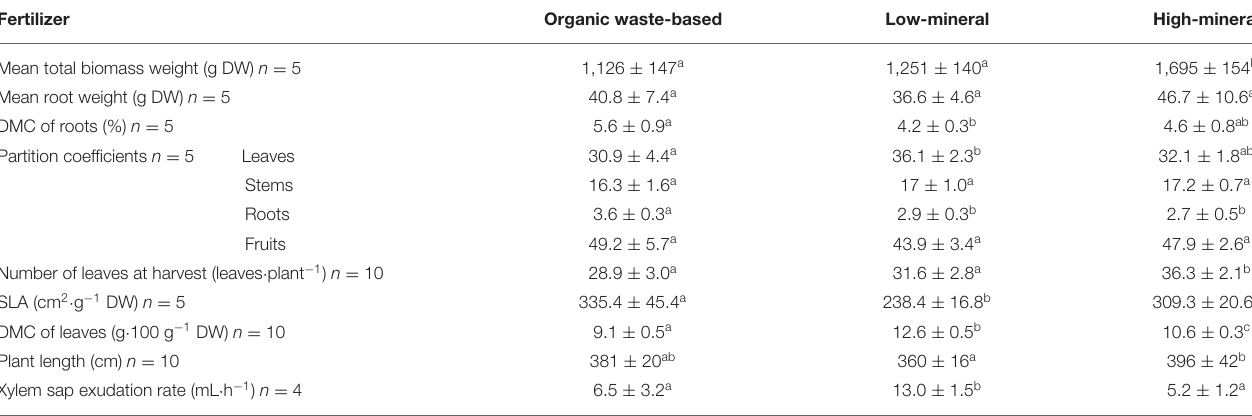
TABLE 3 | Biomass parameters of tomato grown under different nutrient conditions. Fertilizer Organic waste-based